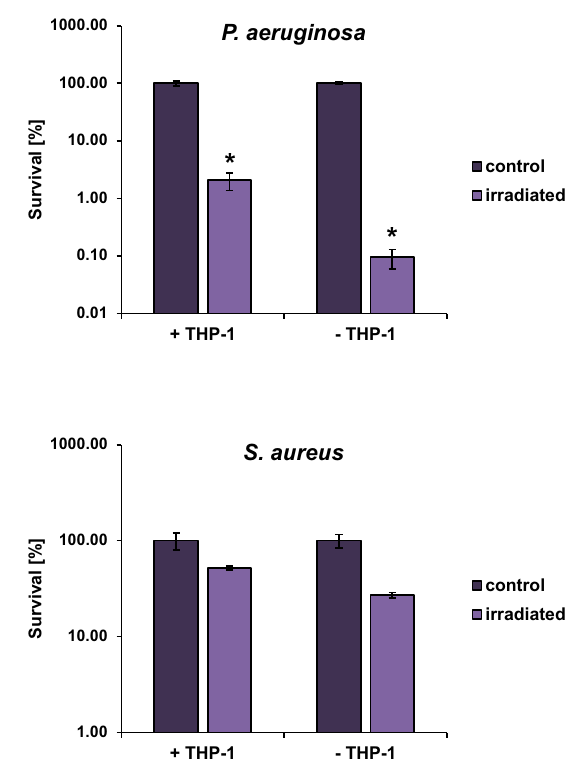
Figure 4. THP-1 infection assay. PMA-stimulated THP-1 cells were infected at a MOI of 1. ( a ) P. aeruginosa (ATCC27853). ( b ) S. aureus (ATCC43300). Incubation of the bacteria without cells served as control. After 1 h incubation, the samples were either irradiated with 405 nm light with a dose of 25 J cm −2 or kept in the dark. Values represent survival of the irradiated samples in comparison to the dark control. The mean and standard deviation of three independent biological replicates with each three technical replicates are illustrated. Statistically significant differences between the irradiated samples and their respective controls are indicated with an asterisk (* p <